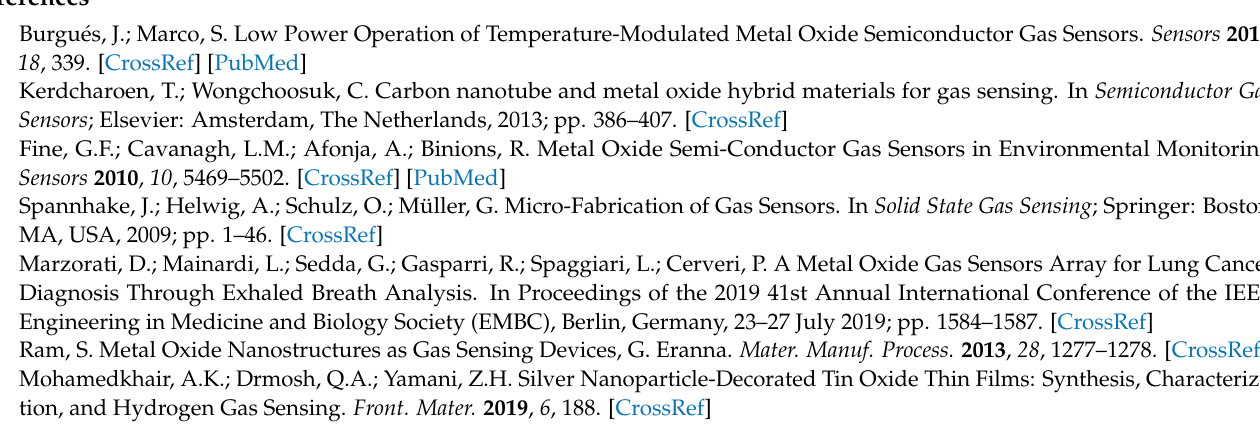
Figure S2: Pore size distributions by nitrogen absorption–desorption obtained by Quantachrome Instruments model NOVA 1000e for the BaSnO 3 , ZnSnO 3 , and CaSnO 3 ceramic